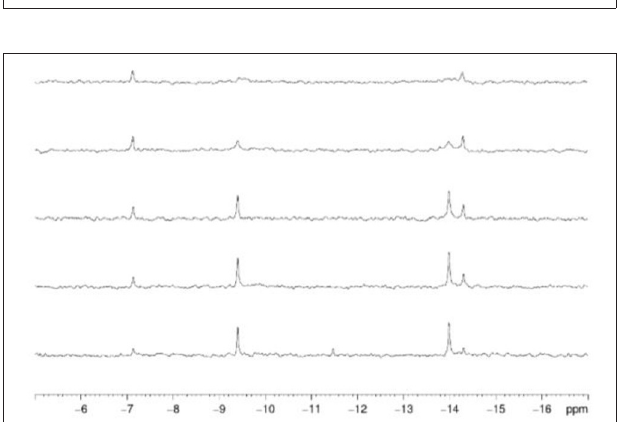
FIGURE 4 | 31 P NMR spectra of Hf1-WD2 (2.0mM) with increasing concentrations of ovalbumin in phosphate buffer (10.0mM, pH 7.4, 10 % D 2 O) after mixing. From bottom to top: 0.0, 0.2mM (10:1), 0.4mM (5:1), 1.0mM (2:1), 2.0mM (1:1) of ovalbumin was added.